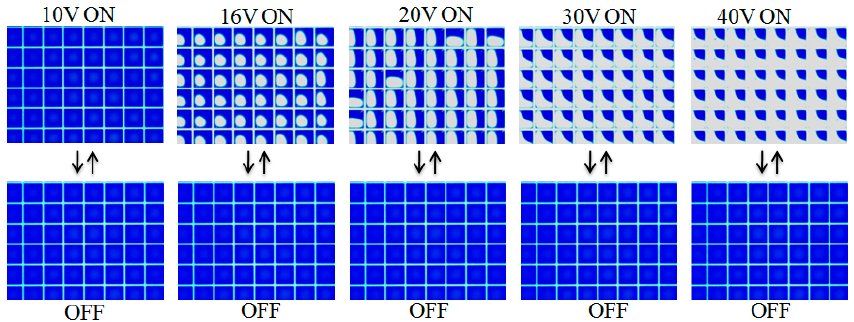
Figure 7. Microscope images of oil movement in each pixel under applied voltage (from 0 V to 40 V). Sixteen volts was needed to activate all the pixels, 20 V to achieve ~50% open area, and 30 V to drive the colored oil to the pixel corners.